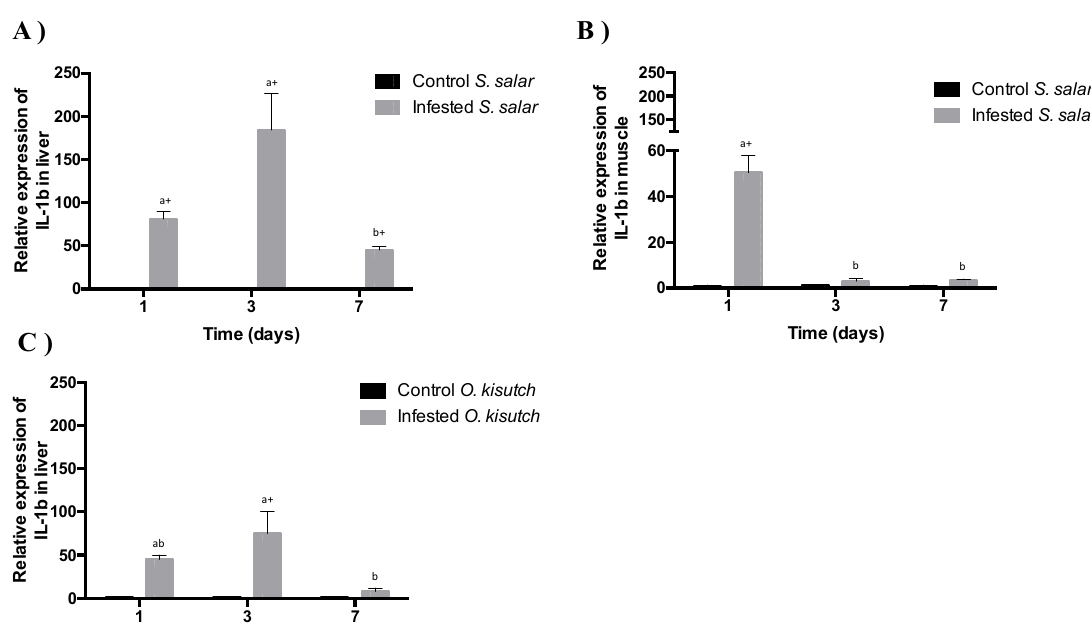
Figure 3. Relative expression of IL-1 β transcripts in Salmo salar muscle infested with C. rogercresseyi . Relative mRNA expression of IL-1 β in muscle at 1, 3, and 7 dpi ( B ) and relative mRNA expression of IL-1 β in liver at 1, 3, and 7 dpi ( A , C ). The 18s gene was used as a reference gene to calibrate the cDNA template for all samples. Bars represent the mean values (± S.E.) of 20 samples. Letters (a,b,c) represent statistical differences within the same group over time. The + symbol represents statistical differences at the same time-point between groups (i.e., infested vs. control). Statistical differences were established by two-way ANOVA ( P < 0.05).